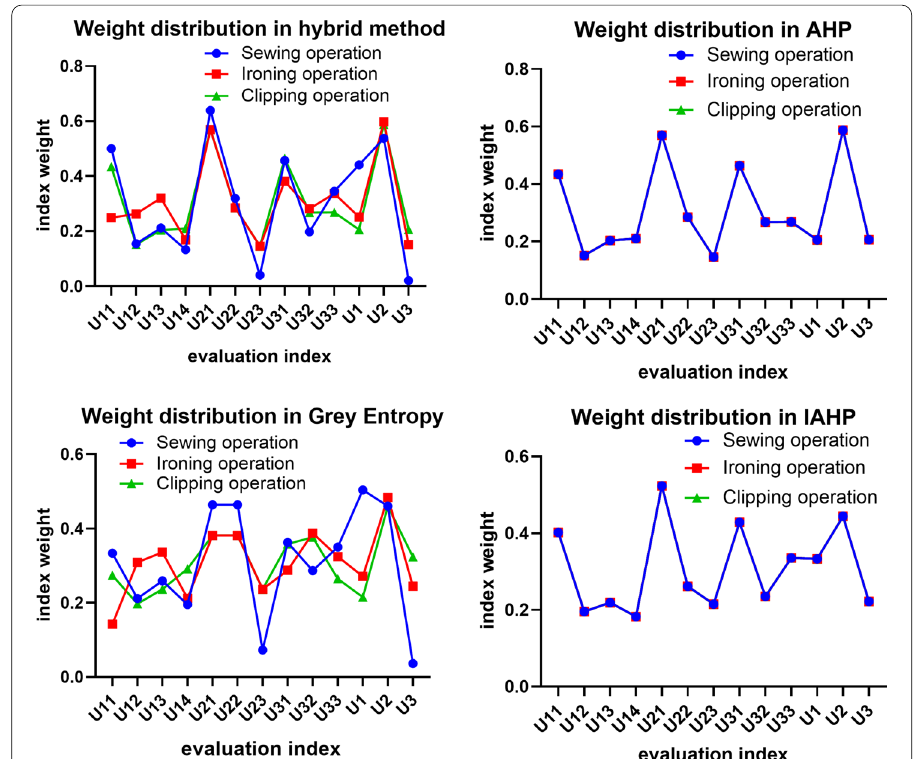
Fig. 7 Analysis of index weight distribution for the four